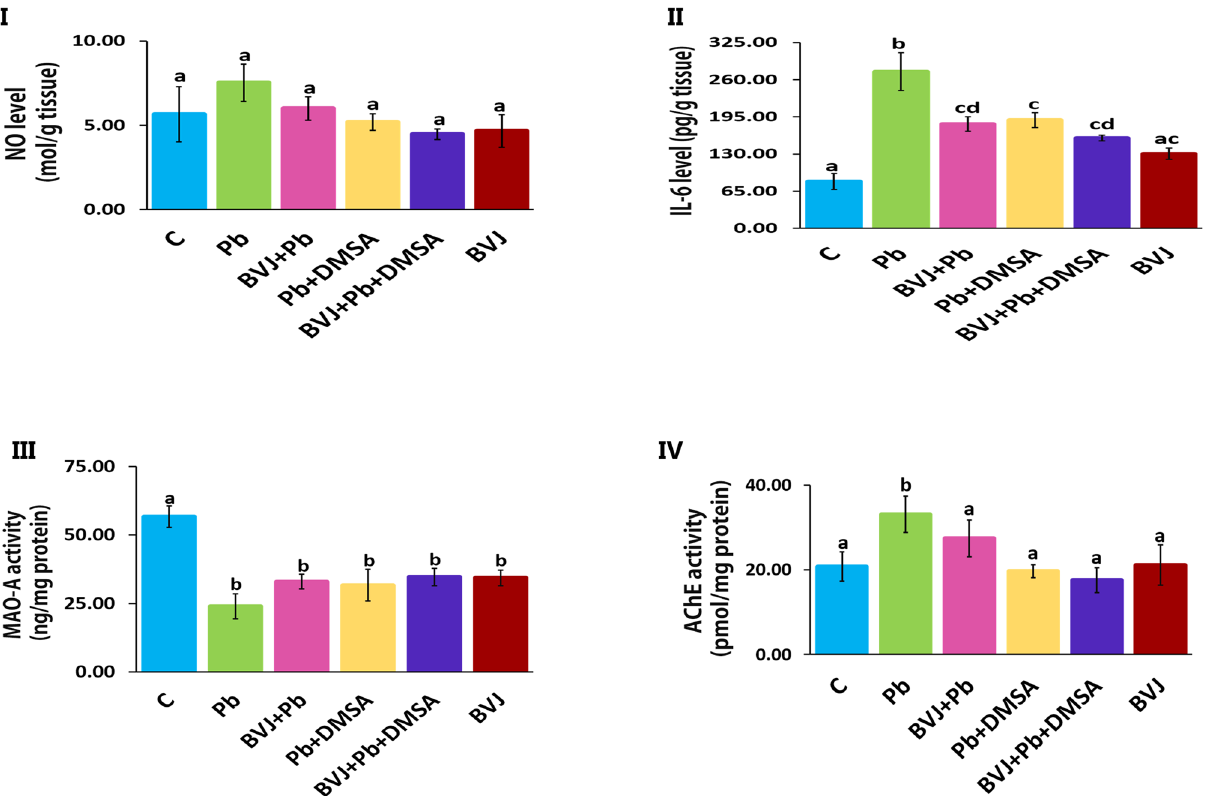
Figure 4. The alleviating effects of Beta vulgaris juice (BVJ), dimercaptosuccinic acid (DMSA), and their combination (BVJ + DMSA) on Pb-induced inflammation and disturbance to the neurotransmitters-associated enzymes in brain tissue of Pb-intoxicated rats. Where ( I ): nitric oxide (NO) level in the brain tissue of all the studied groups, ( II ): interleukin (IL)-6 level in the brain tissue of all the studied groups, ( III ): the activity of monoamine oxidase (MAO)-A in the brain tissue of all the studied groups, and ( IV ): the activity of acetylcholine esterase (AChE) in the brain tissue of all the studied groups. The results are shown as mean ± SE (n = 8). Different letters for the same parameter are significantly different at p < 0.05. C